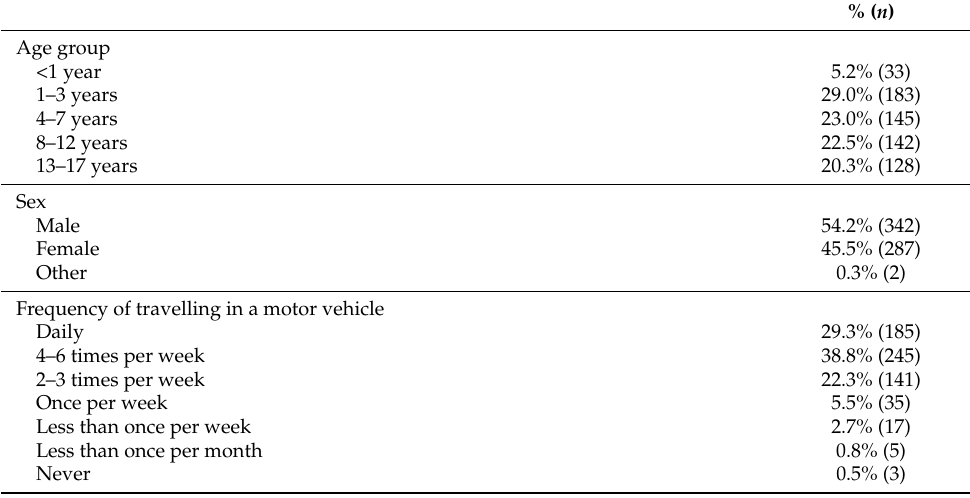
Table 3. Participants’ youngest child characteristics, restraint, and travel patterns ( n =